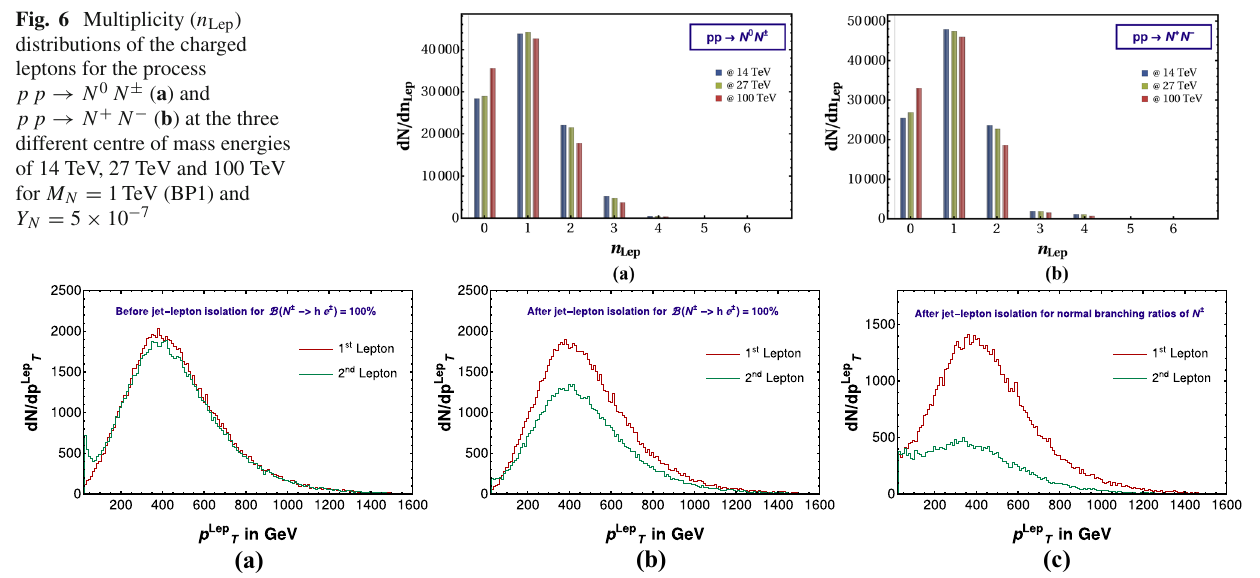
Fig. 7 The transverse momentum ( p T ) distributions of charged lep- tons (1st and 2nd) at the LHC for the process p p → N + N − with M N = 1 TeV, Y N = 5 × 10 − 7 and center of mass energy 14 TeV. a and Fig. 8 Jet multiplicity ( n Jet ) distributions for the process p p → N 0 N ± ( a ) and p p → N + N − ( b ) at E CM = 14 TeV, 27 TeV and 100 TeV for Y N = 5 × 10 − 7 and M N = 1TeV (BP1)